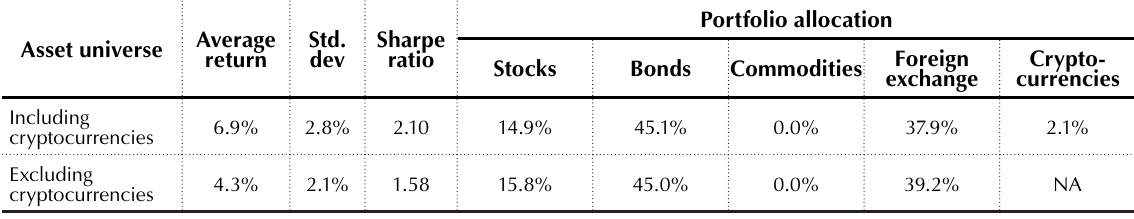
Table 5. Comparison of tangency portfolios, annual performance Asset